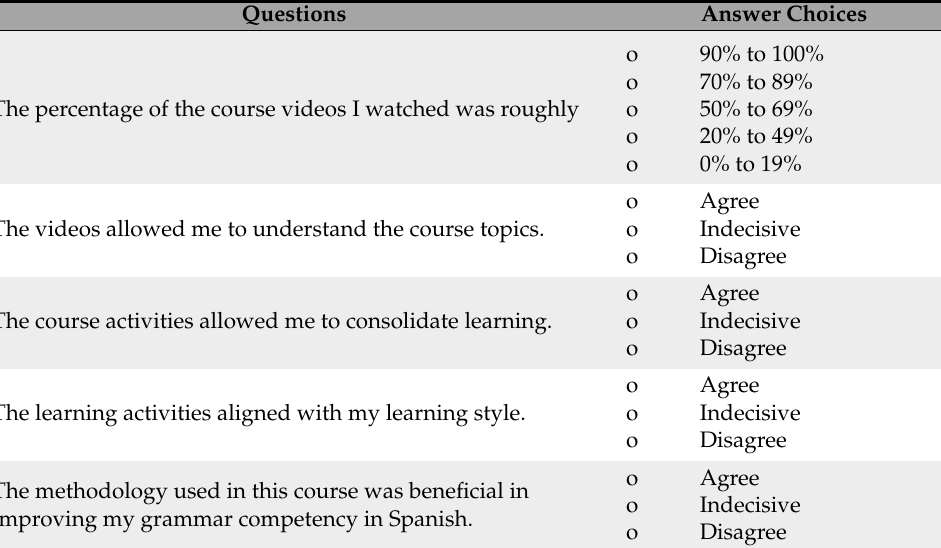
Table 6. Opinion survey questions for students about the course taught in the virtual Flipped Classroom model, supported by videos from the YouTube social